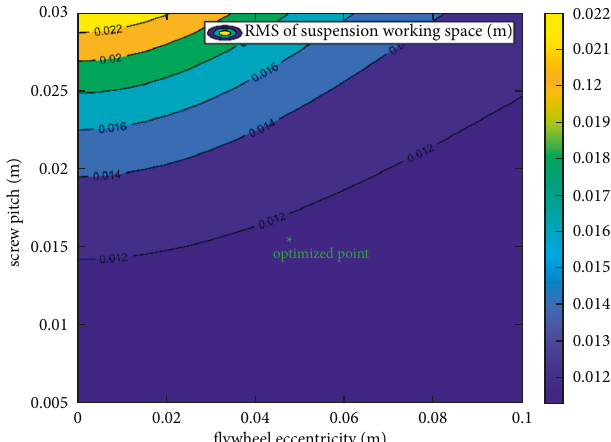
Figure 12: The change of suspension working space subject to the change of flywheel and screw pitch in the series model.